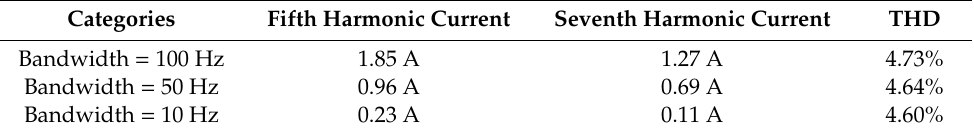
Table 6. Performances of the SHE method for di ff erent the bandwidths.